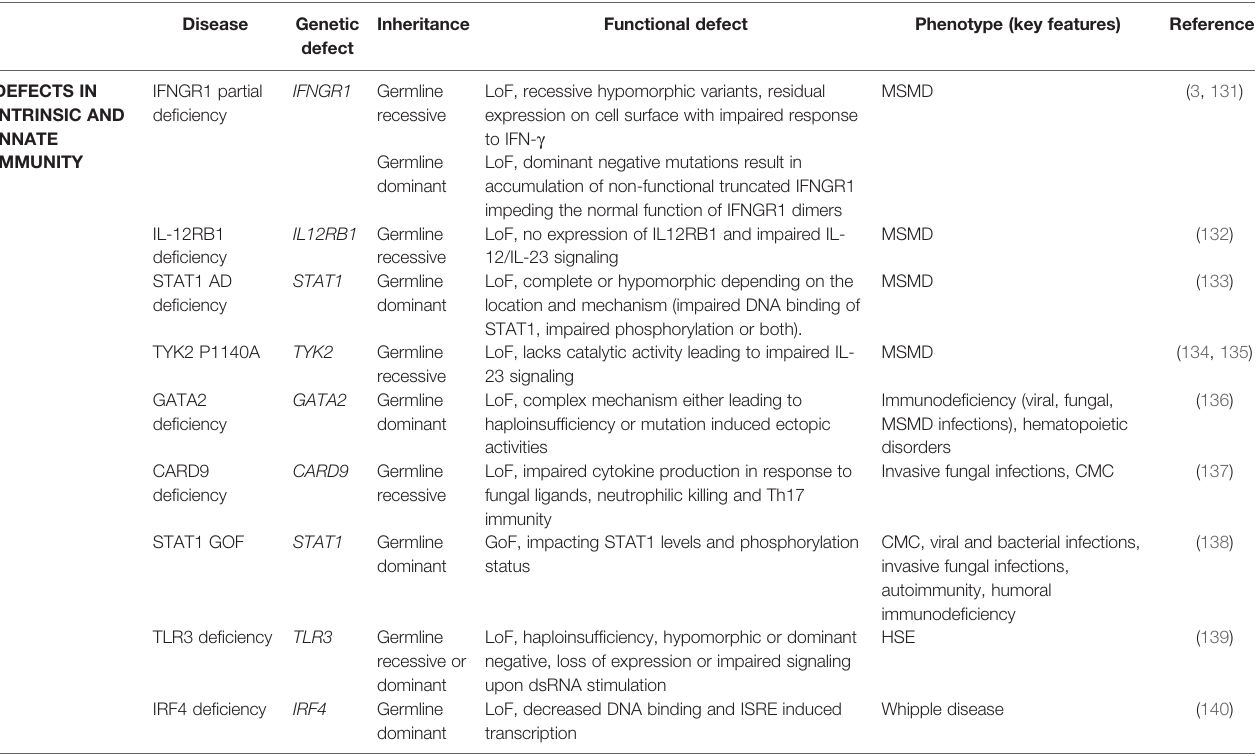
TABLE 5 | Genes associated with adult-onset defects in intrinsic and innate